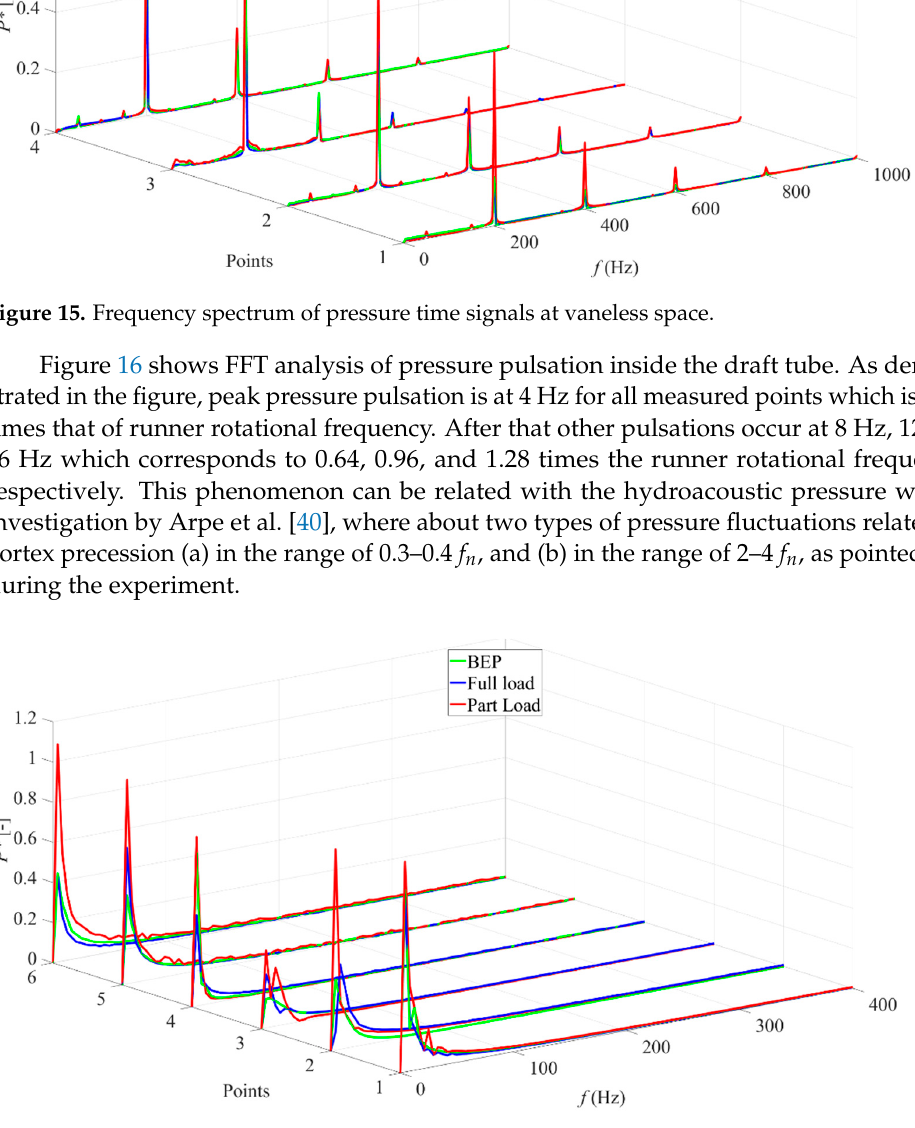
FFT plot of pressure fluctuation from points RV1 to RV6 along the runner blade is